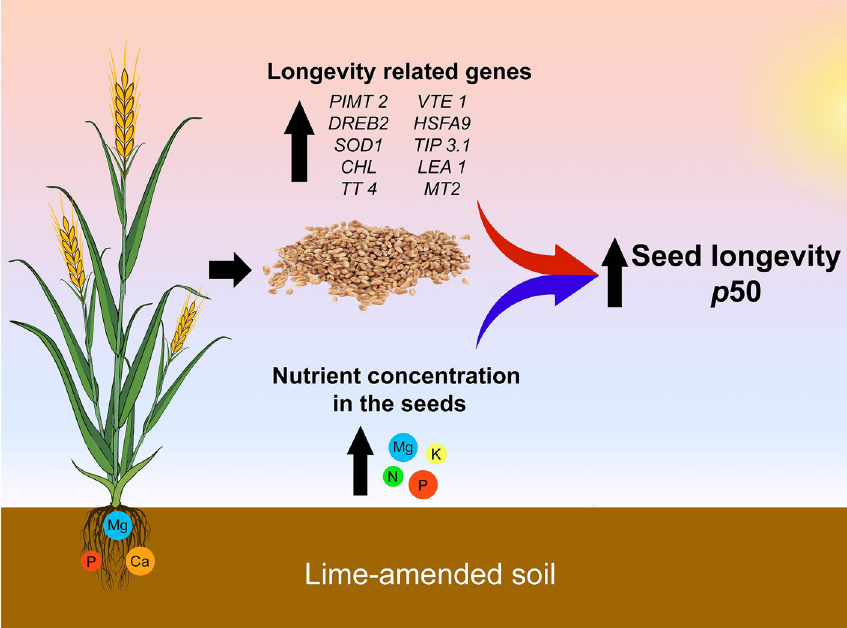
Figure 4. Summarized results of this study representing the cascading effects of improving soil fertility on seed nutrient content, longevity related genes, and p